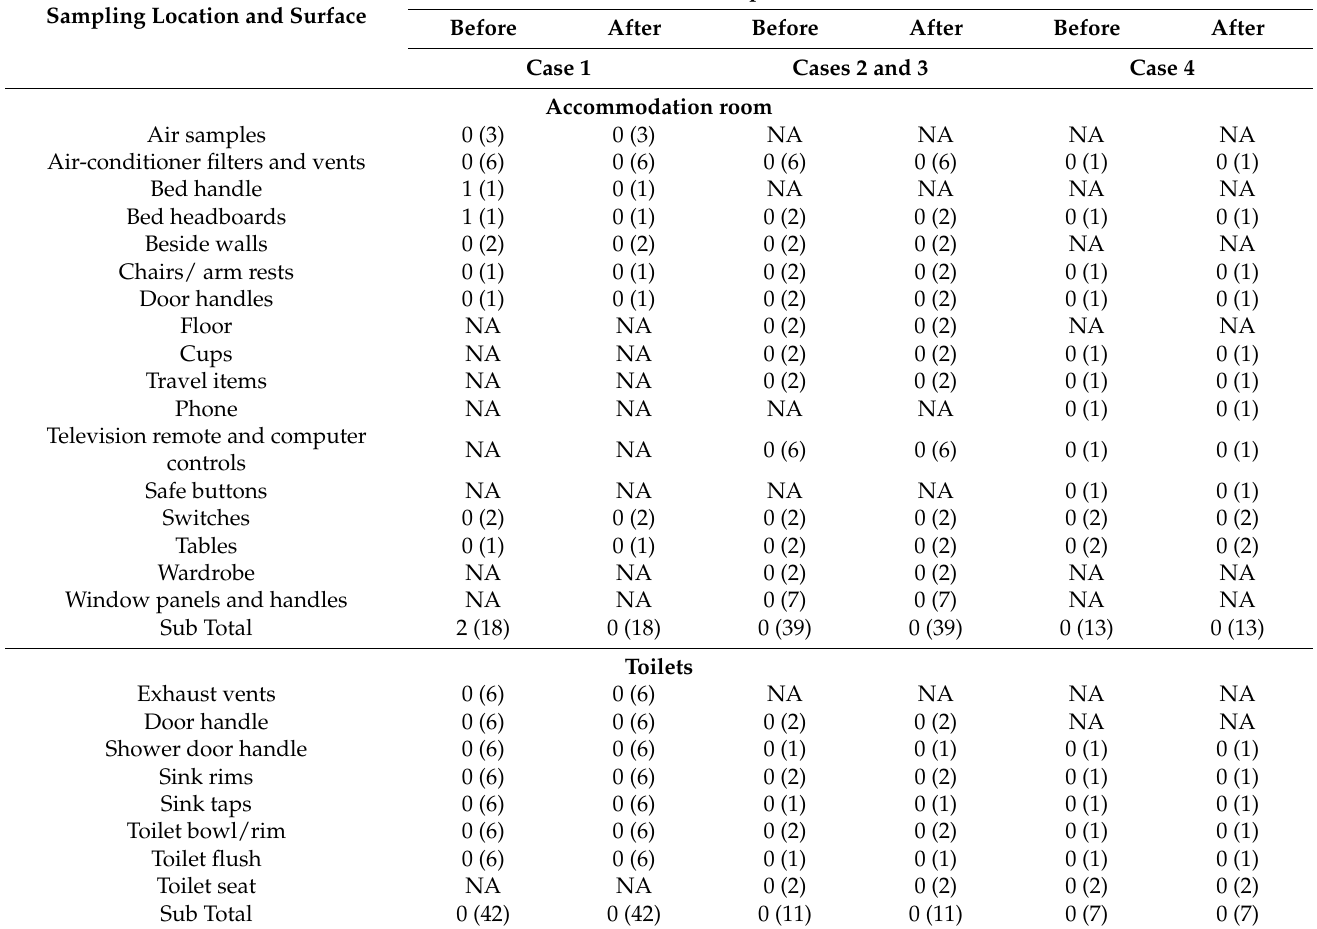
Table 3. Environmental samples and corresponding nested RT-PCR